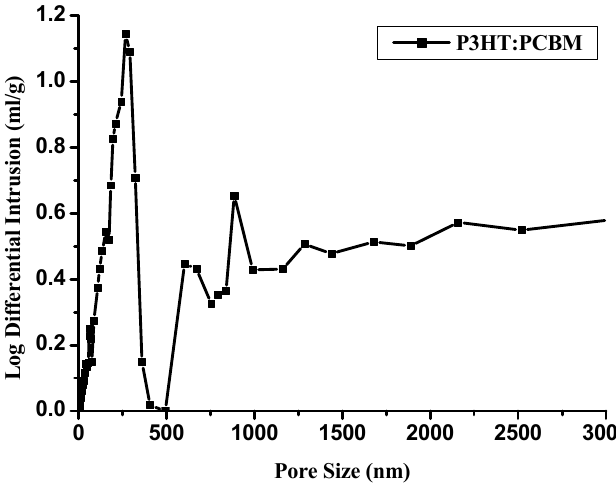
Figure 2. ( a ) Porosity and ( b ) pore size distribution of the porous conductive